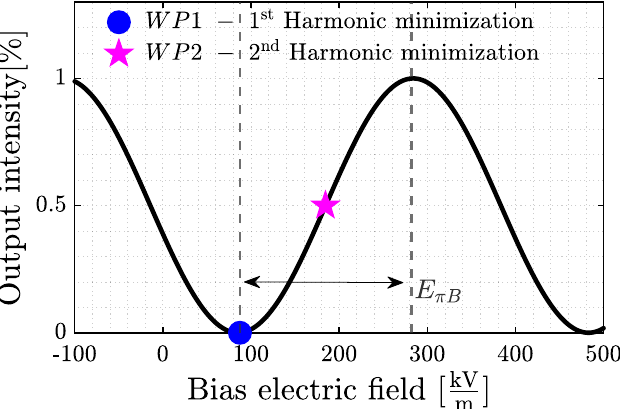
Figure 3. Transfer function of the system.